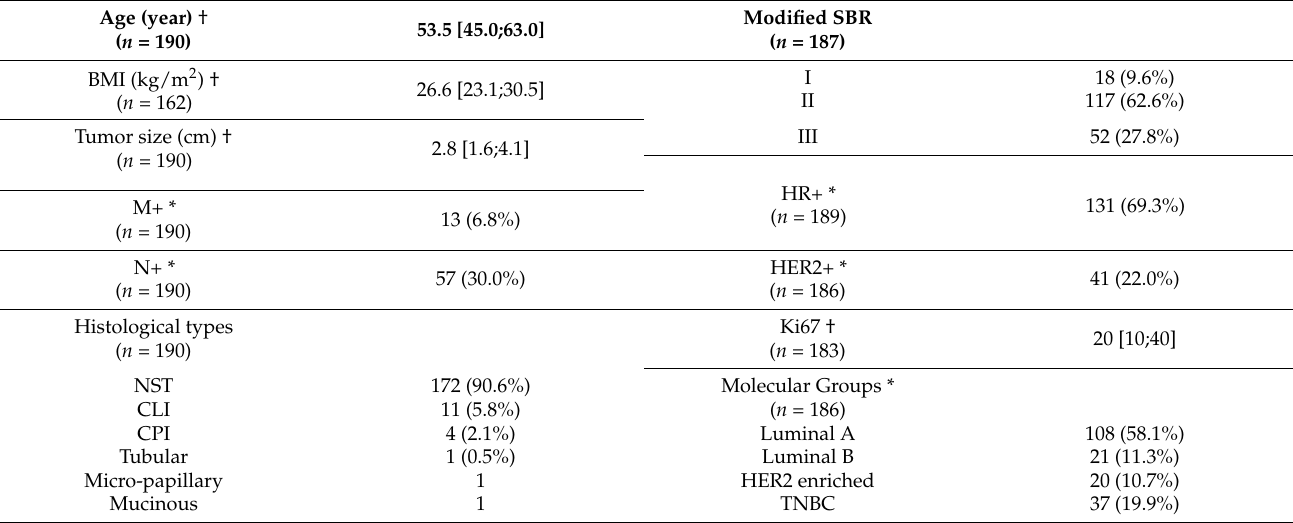
Table 1. General clinical and histological features at diagnosis ( n =